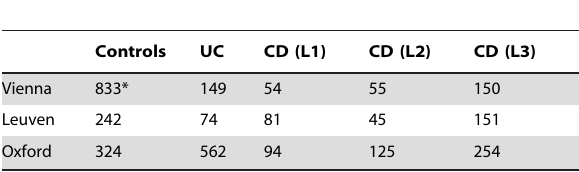
Table 1. Overview of the origin of samples from IBD patients and healthy